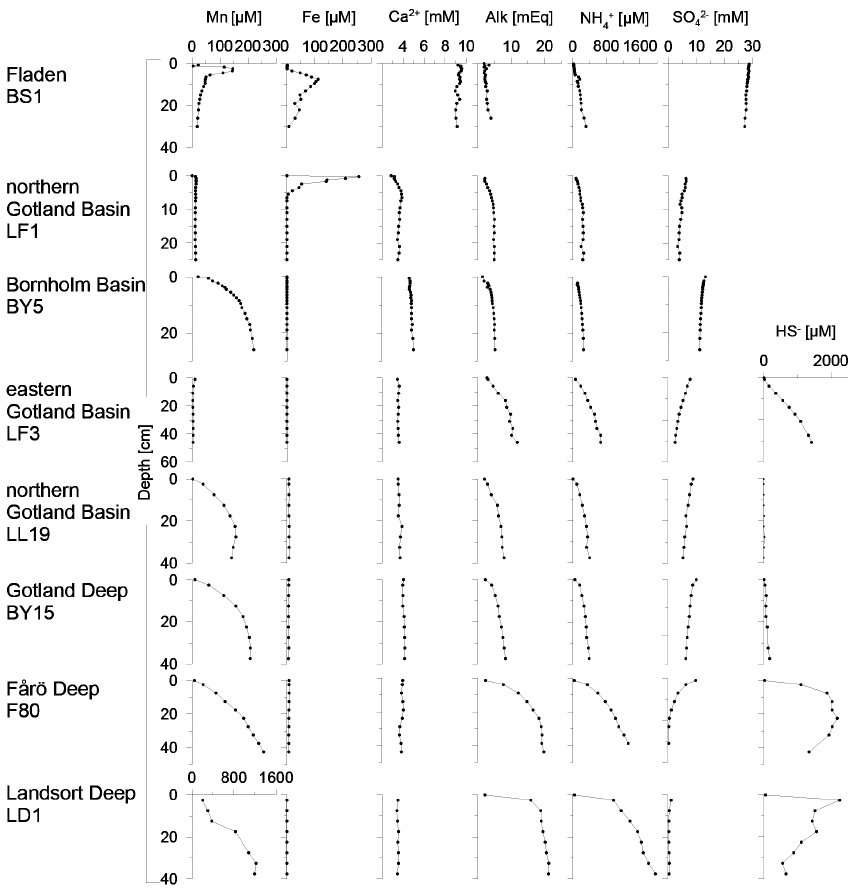
Figure 2. Pore water profiles of dissolved manganese (Mn), iron (Fe), calcium (Ca), alkalinity, ammonium and sulfate for all eight sites, and hydrogen sulfide for the five deepest sites. Note that dissolved Fe is below the detection limit in core LF3 and LD1 and dissolved sulfide is expressed as HS − ; some H 2 S can be present as well.